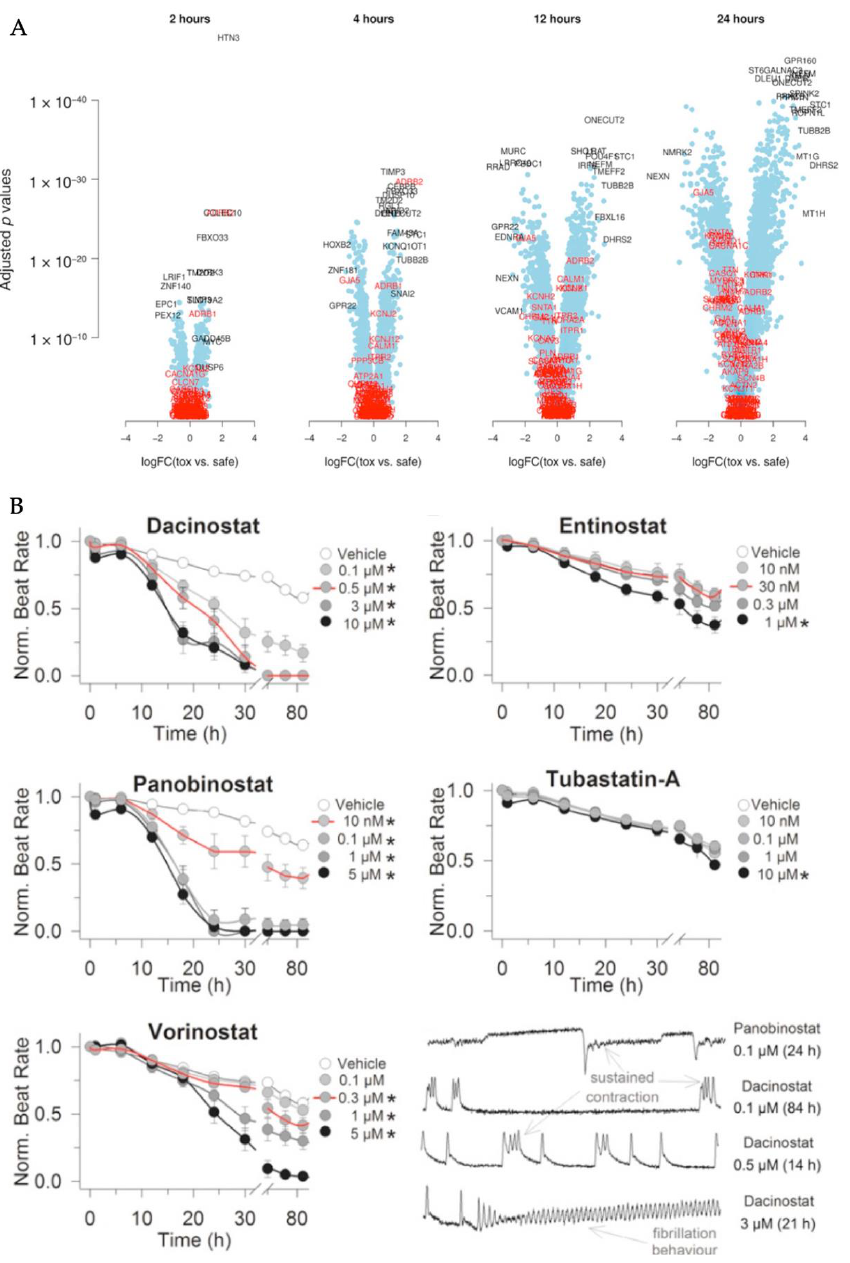
Figure 6. ( A ) Volcano plot illustrates time-dependent transcriptional changes between treatments defined as “toxic” (0.5 mM dacinostat, 0.1 mM and 0.01 mM panobinostat, and 5 mM and 0.2 mM vorinostat) and treatments defined as relatively “safe” (0.3 mM entinostat, 1 mM tubastatin-a, and 0.1 mM vorinostat). Top 10 (based on p -value and log ratios, possibly overlapping) differential genes are in black while genes related to cardiac contractility and function are in red. ( B ) Time-dependent changes in beat rate reveal toxic effects of tested HDACi. Red line indicates applicable C eff . * p < 0.05. Reproduced with permission from [133].